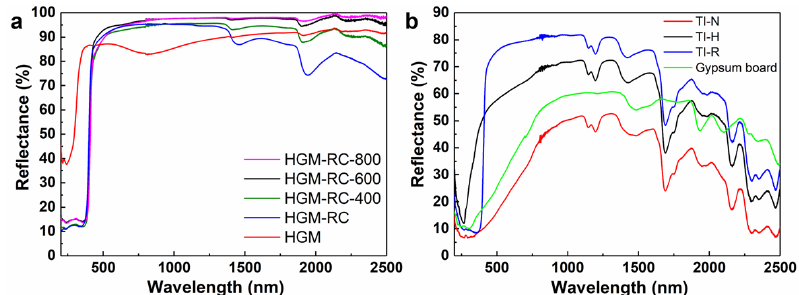
Figure 7. ( a ) UV-vis-NIR diffuse reflection spectra of pristine HGM and TiO 2 -coated HGM calcined at different temperatures; ( b ) UV-vis-NIR diffuse reflection spectra of uncoated gypsum board and different coatings on the surface of the gypsum board.